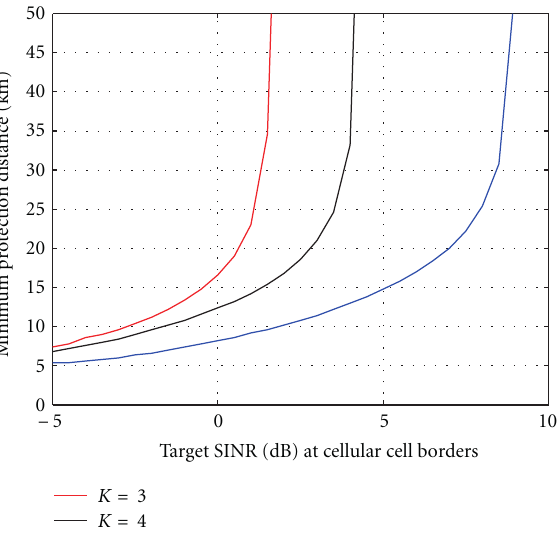
Figure 3: Minimum protection distance satisfying TV and secondary system cell coverage constraints with respect to di ff erent cellular SINR target γ t . Di ff erent reuse distances K are tested. The cell radius is taken equal to 1km. The rest of the parameter settings are the same used in Section